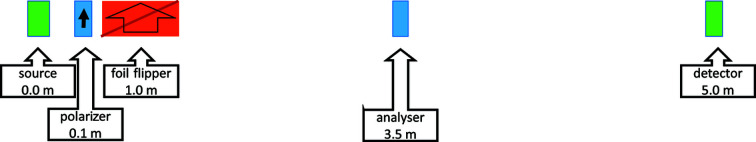
Schematic drawing of the configuration to test a single foil flipper. Distances, sizes and angles are not to scale. To test the functioning of the foil flipper, the polarizer sets the neutron polarization in the positive vertical direction, the non-precession mode. In the SE(M)SANS modes the polarizer sets the neutron polarization in the horizontal direction. The arrow in the foil flipper indicates the direction of the magnetic field. The analyser can be oriented in the positive or negative direction to measure either the up or down intensity.